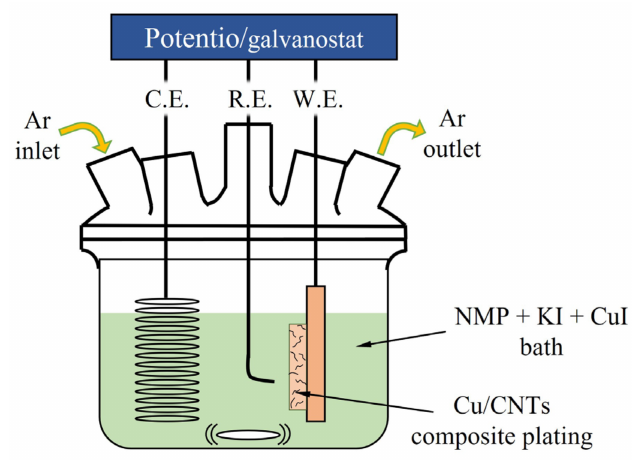
Figure 1. Schematic of the electrolysis